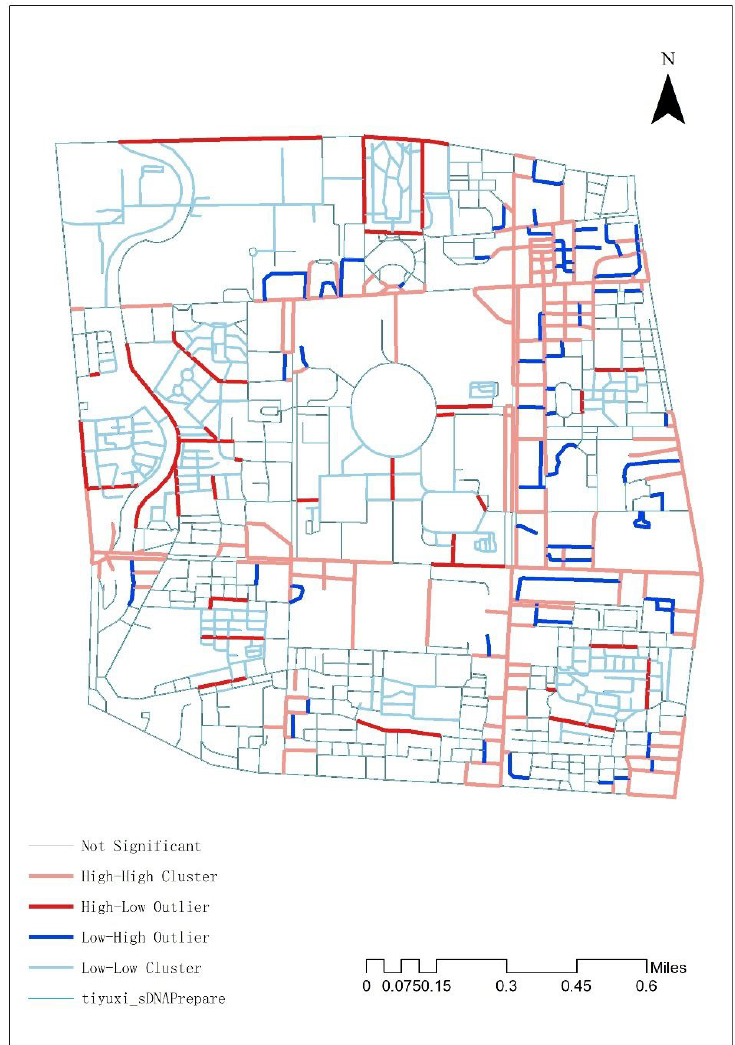
Fig. 4 Local Moran index analysis of global integration calculation of Tianhe Sports Centre and its